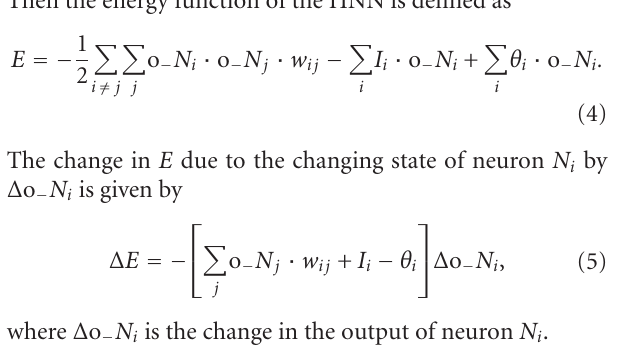
Figure 17: PV output power under drastic irradiation change from 1000 W/m 2 to 950 W/m 2